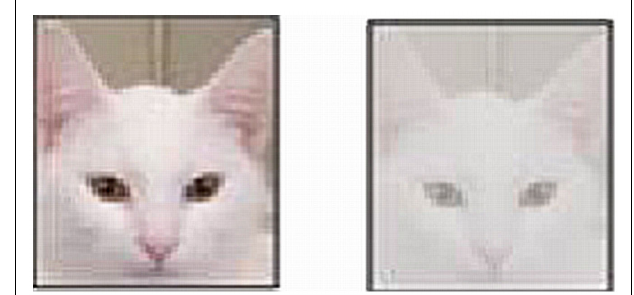
FIGURE 3 | Examples of pictures used by Overgaard and Overgaard (2010) to illustrate the perception according to different subjective levels of